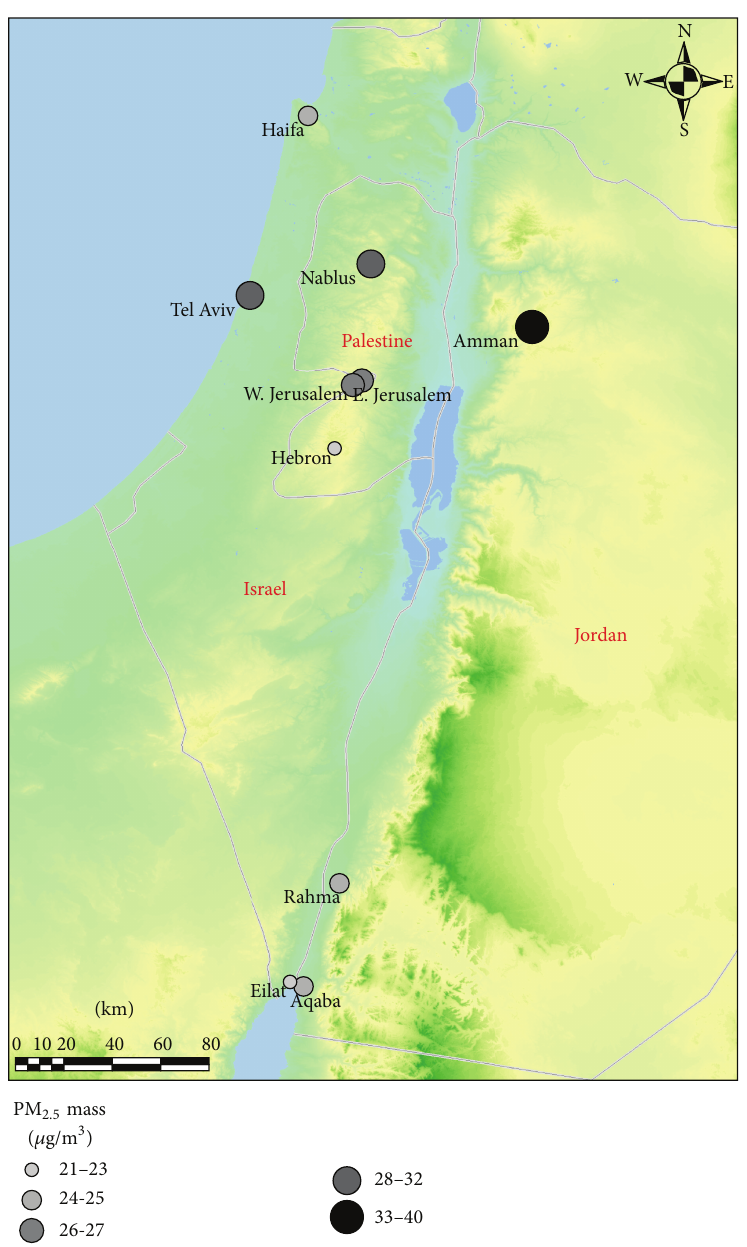
Figure 1: Sample site locations and their annual average PM 2.5 mass